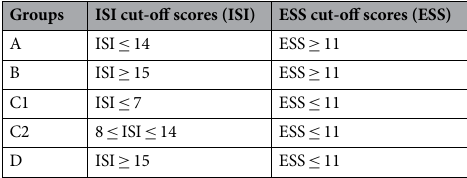
Table 5. The group notation table.